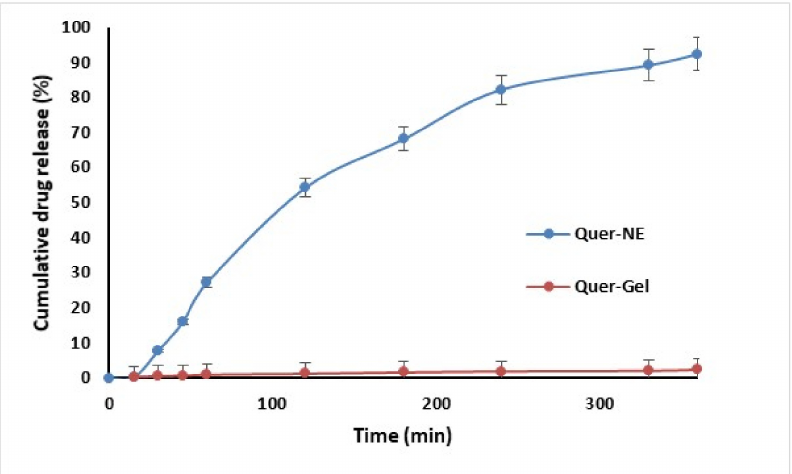
Figure 4. In vitro drug diffusion profile.